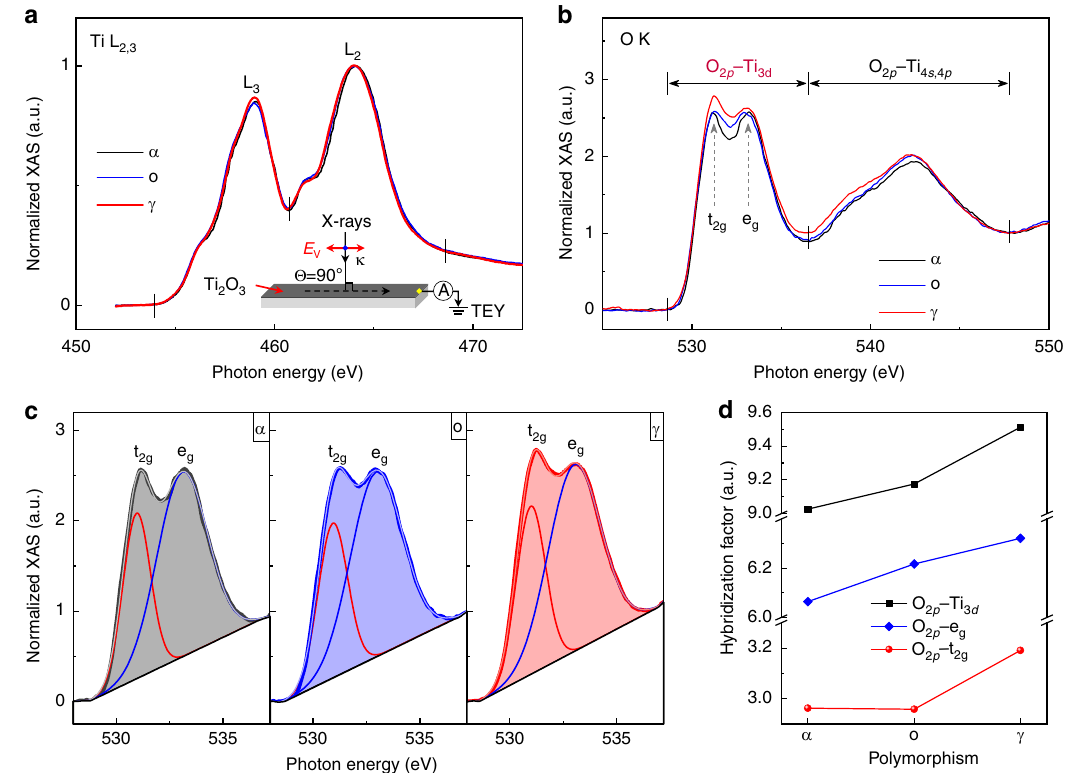
Fig. 4 Hybridization strength of the Ti – O orbitals in different Ti 2 O 3 polymorphs. a Ti L 2,3 -edge and ( b ) O K -edge XAS spectra of the Ti 2 O 3 polymorphs, collected in the TEY mode at room temperature. The experimental con fi guration is shown as inset in ( a ). The intensity of the O- K edge XAS spectra in ( b ) are normalized at 547.7eV. c Fitting and ( d ) Integrated intensities of the O K -edge pre-edge region (from 528 to 537.2 eV) with subtraction of the linear backgrounds for Ti 2 O 3 polymorphs. The hybridization factor (H.F.) for O 2 p -e g and O 2 p -t 2 g is obtained by calculating the integrated intensities of the fi tted e g (blue lines in c ) and t 2 g (red lines in c ) curves. Source data are provided as a Source Data fi